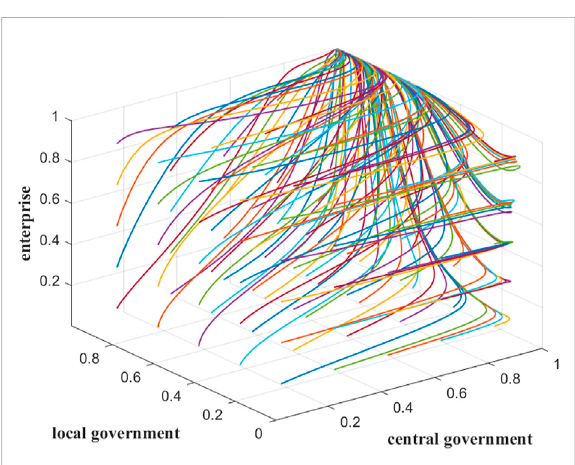
FIGURE 3 Ideal state simulation diagram. Note: The initial values of the variousparametersareC 1 =4,C 2 =3,C 3 =2,E=20,F 1 =15,F 2 =15, L = 8, γ = 0.5, p = 2, N = 10, Q = 15, S = 5, and R =